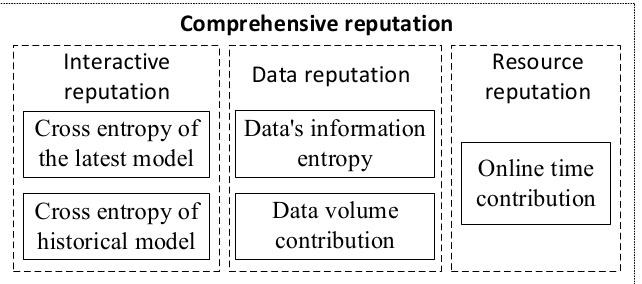
Figure 4. Reputation evaluation method.